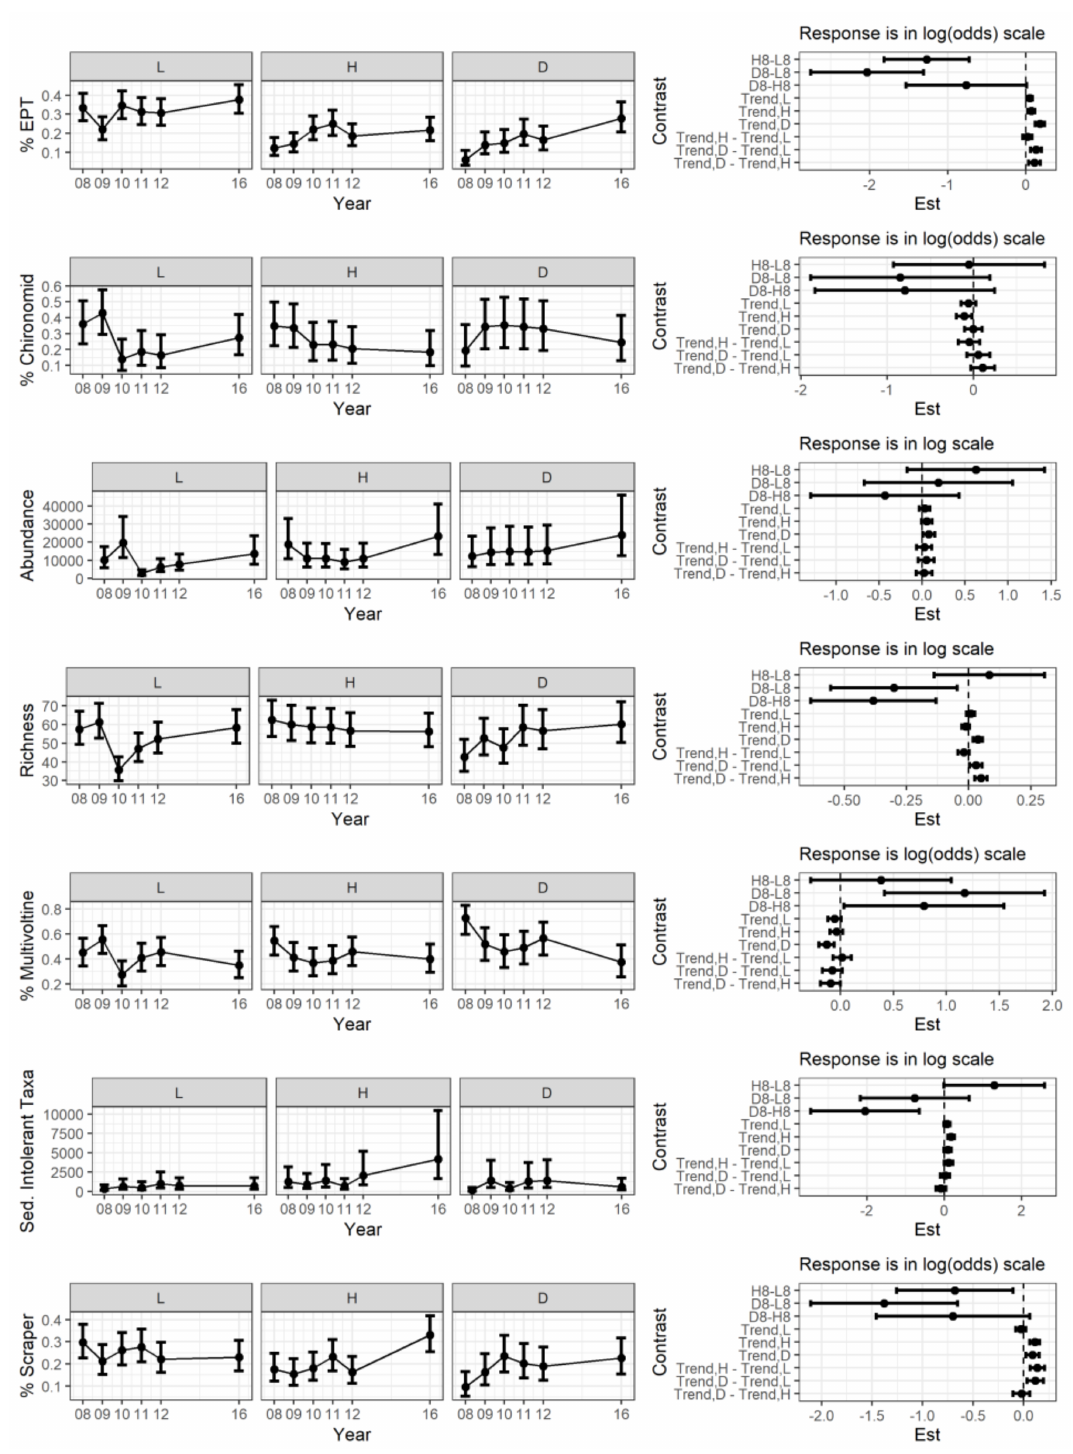
Figure 6. Estimated marginal means with 90% C.I.s of eight macroinvertebrate metrics after storm in 2008 to 2016 at low flood ( L ), high flood ( H ), and debris flow ( D ) disturbance categories (left) and sets of contrasts differences in 1st year response (1–3), differences in trend through time (4–6), and of differences in trend between categories (7–9) (right panel). Estimates of minimum temperature were 13 to 15 ◦ C in L, 14 to 16 ◦ C for H, and 13 to 15 ◦ C for D reaches. There was also an increase in minimum temperature observed at both L and H reaches for three years (2010–2012) (Figure 4). No changes in minimum temperatures were observed at D reaches (Figure 4, contrast